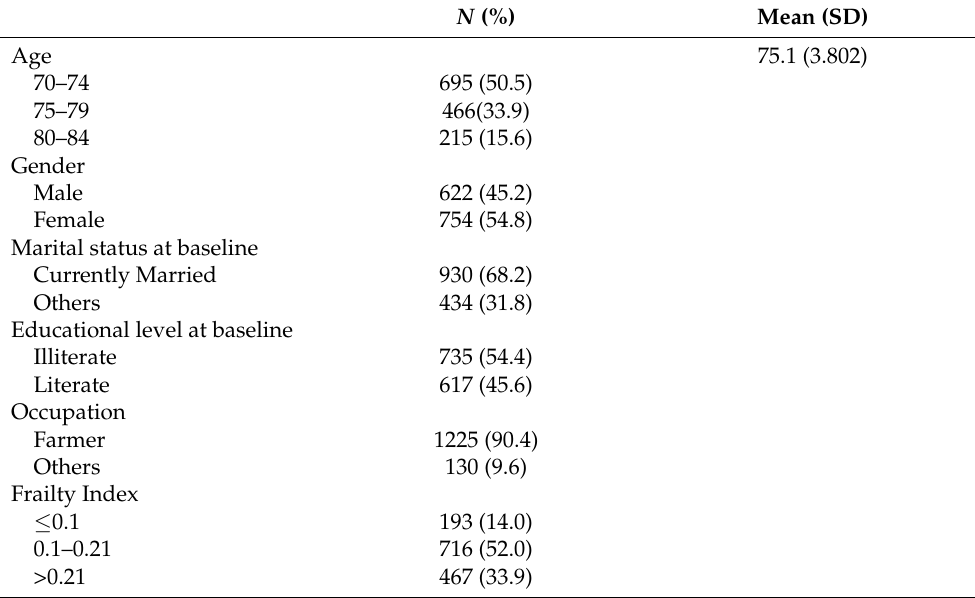
Table 1. Demographic and health characteristics of participants at baseline (N =